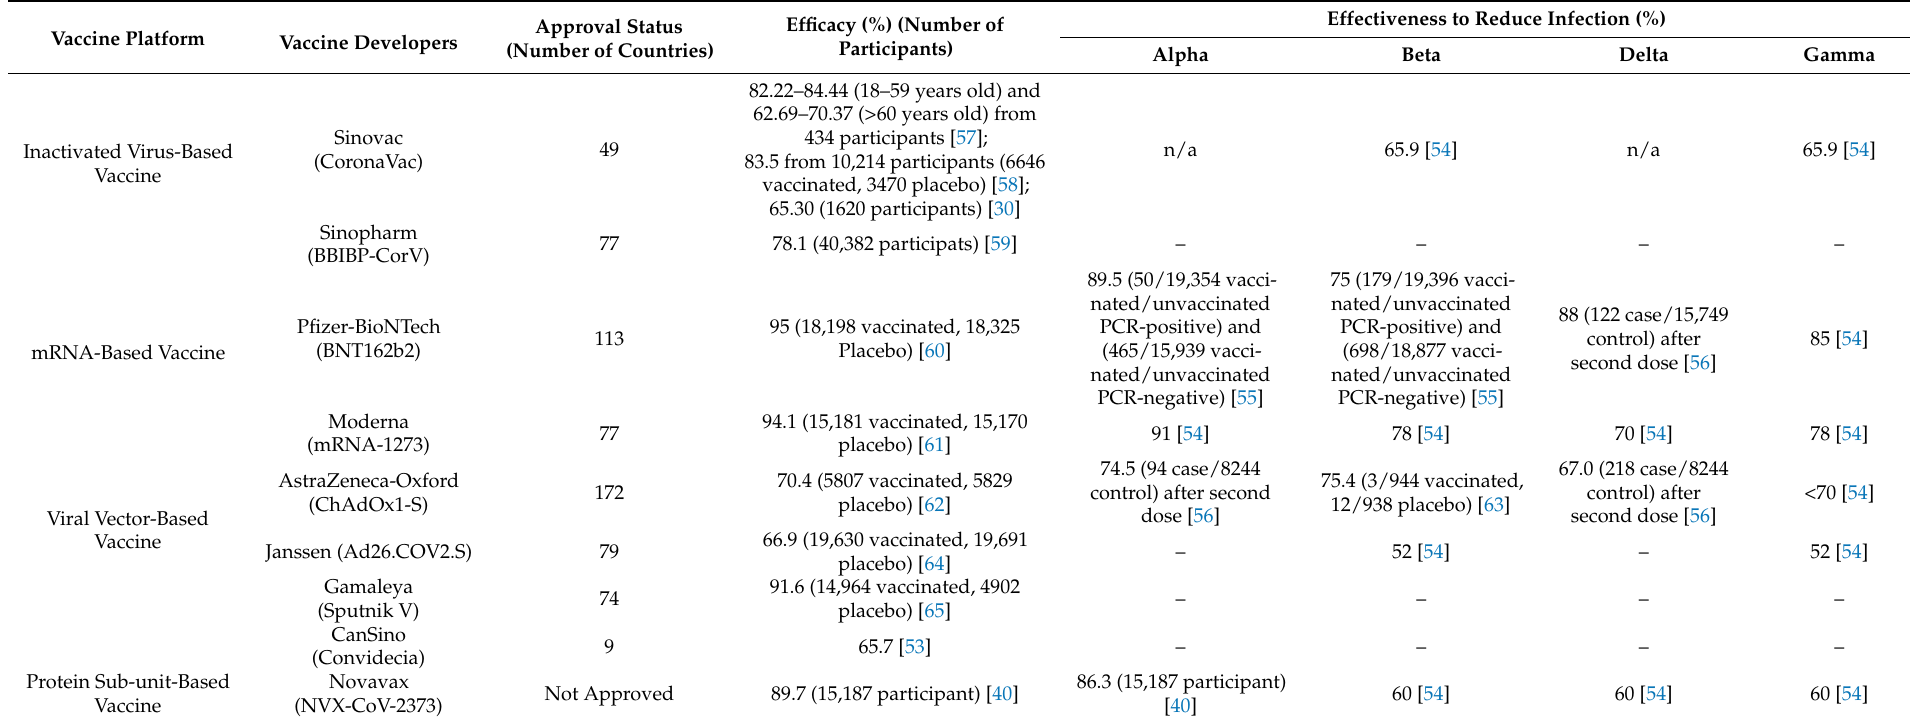
Table 2. Efficacy and effectiveness of COVID-19 vaccines that have received emergency use authorization against various SARS-CoV-2 variants